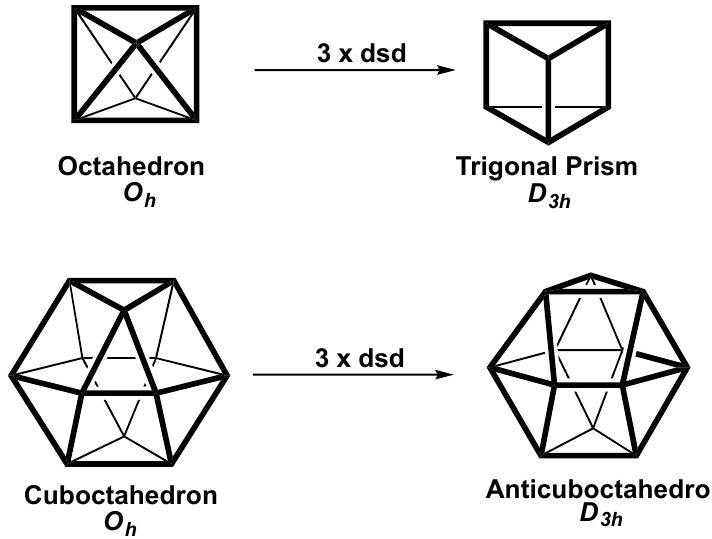
Figure 6. Polyhedra with octahedral ( O h ) symmetry and their conversions by a triple diamond-square-diamond process to a polyhedron with D 3 h symmetry.